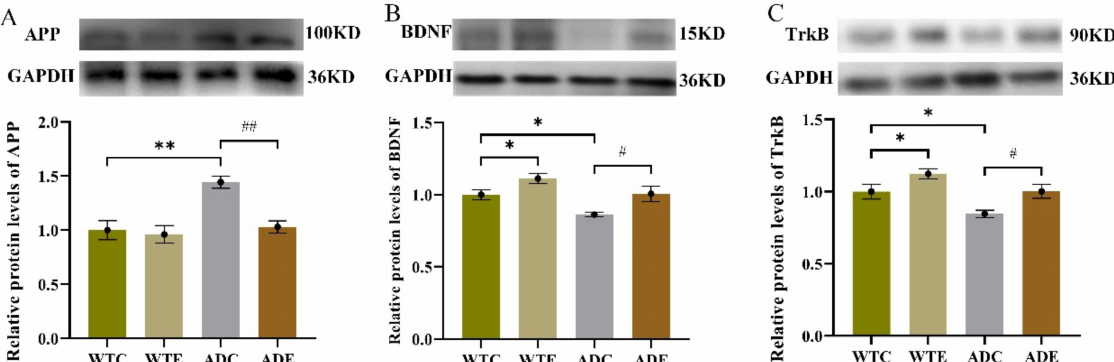
Figure 6. Effect of treadmill exercise on various protein levels in mice. ( A ) Relative APP protein levels in the hippocampus. ( B ) Relative BDNF protein levels in the hippocampus. ( C ) Relative TrkB protein levels in the hippocampus. n = 6 for each group. * p < 0.05, ** p < 0.01 compared with WTC. # p < 0.05, ## p < 0.01 compared with ADC.